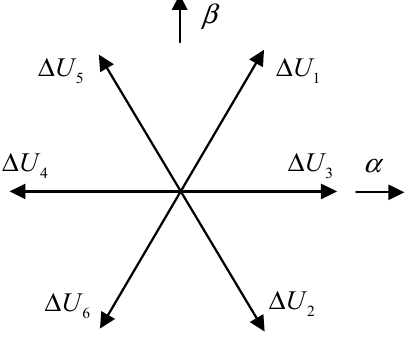
where ∆ U i is the error voltage vector. Its size is shown in Figure 3. The amplitude is simply equivalent to T d U s / T s . Its phase is related to the polarity of the three-phase current. When the polarity of the three-phase currents i a , i b , and i c are positive, and positive and negative, the error voltage vector corresponds to ∆ U 6 .